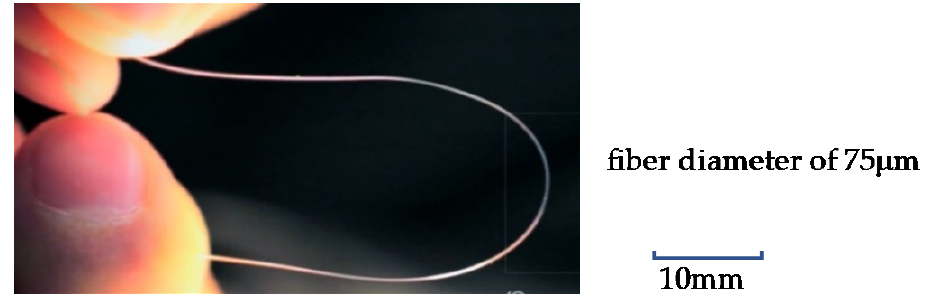
Figure 1. PLLA fiber with practical piezoelectric properties and flexibility for sensing.